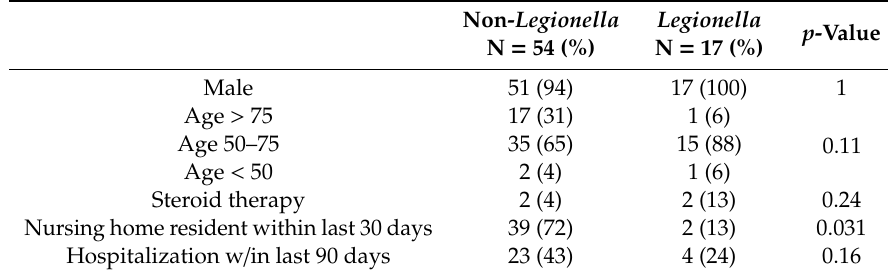
Table 1. Demographic characteristics of pneumonia cases. N: Number, w / in: Within, HIV: Human Immunodeficiency Virus, COPD: Chronic Obstructive Pulmonary Disease. p -Values obtained by Fisher exact or Chi-square testing as